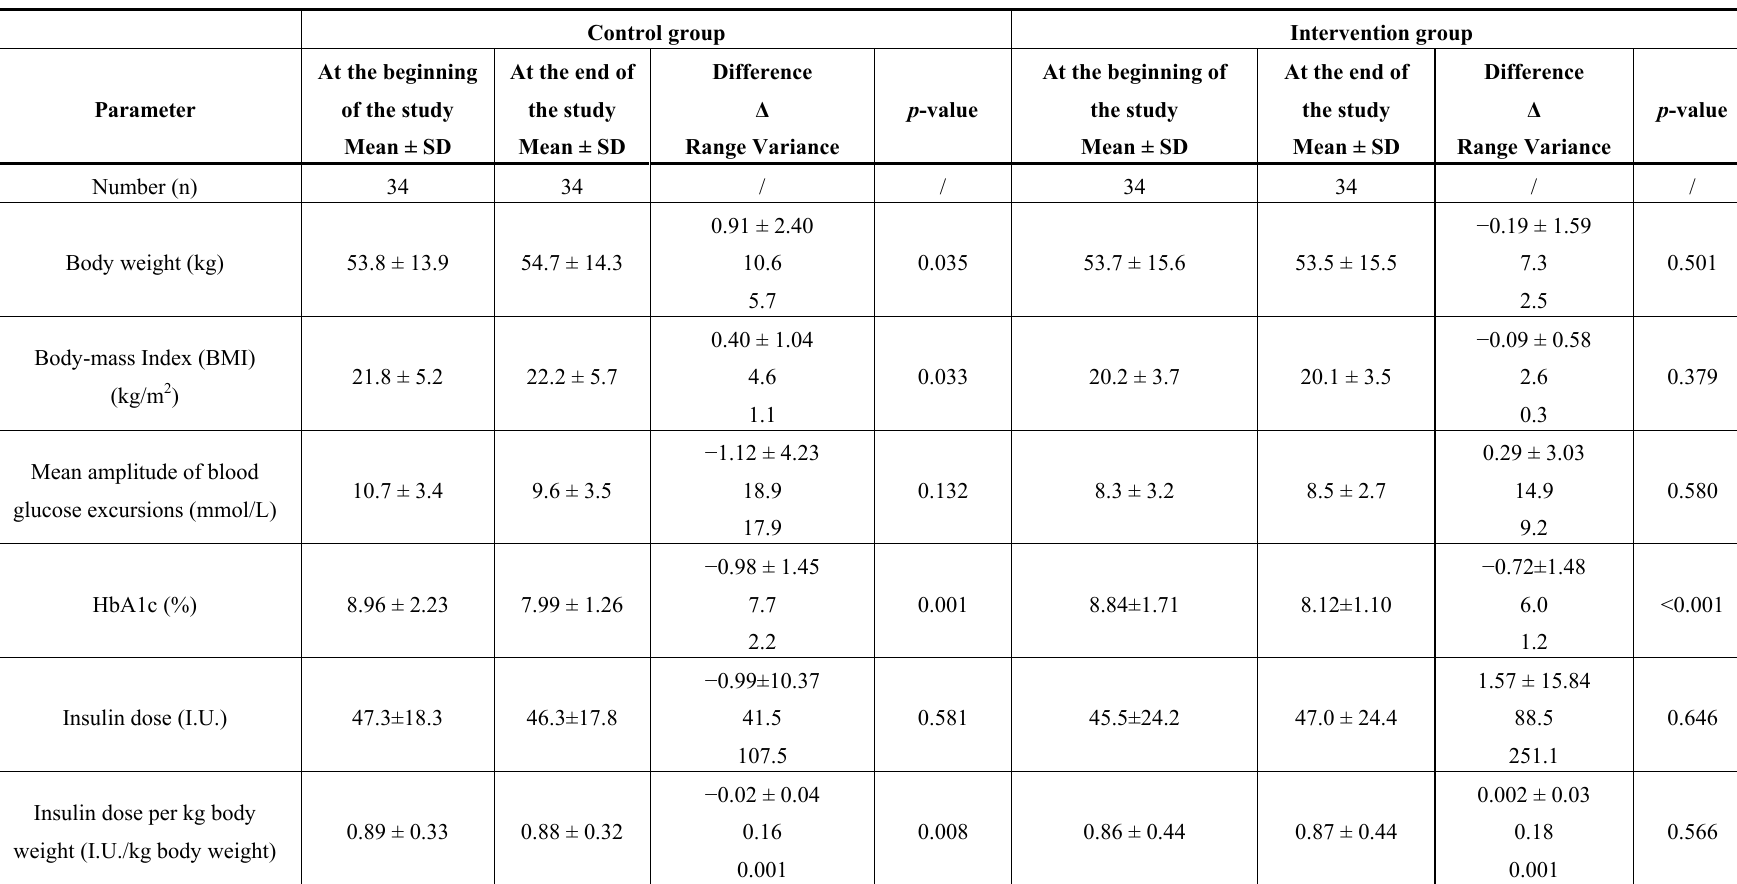
Table 2. Changes of parameters of metabolic control during the study (pairwise (intra-individual) comparison at beginning vs. at the end of the study), Control and intervention groups ( n = 68 subjects with type-1 diabetes